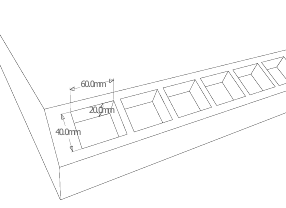
Figure 13. Schematic diagram of the seam of CLHCPCS size.